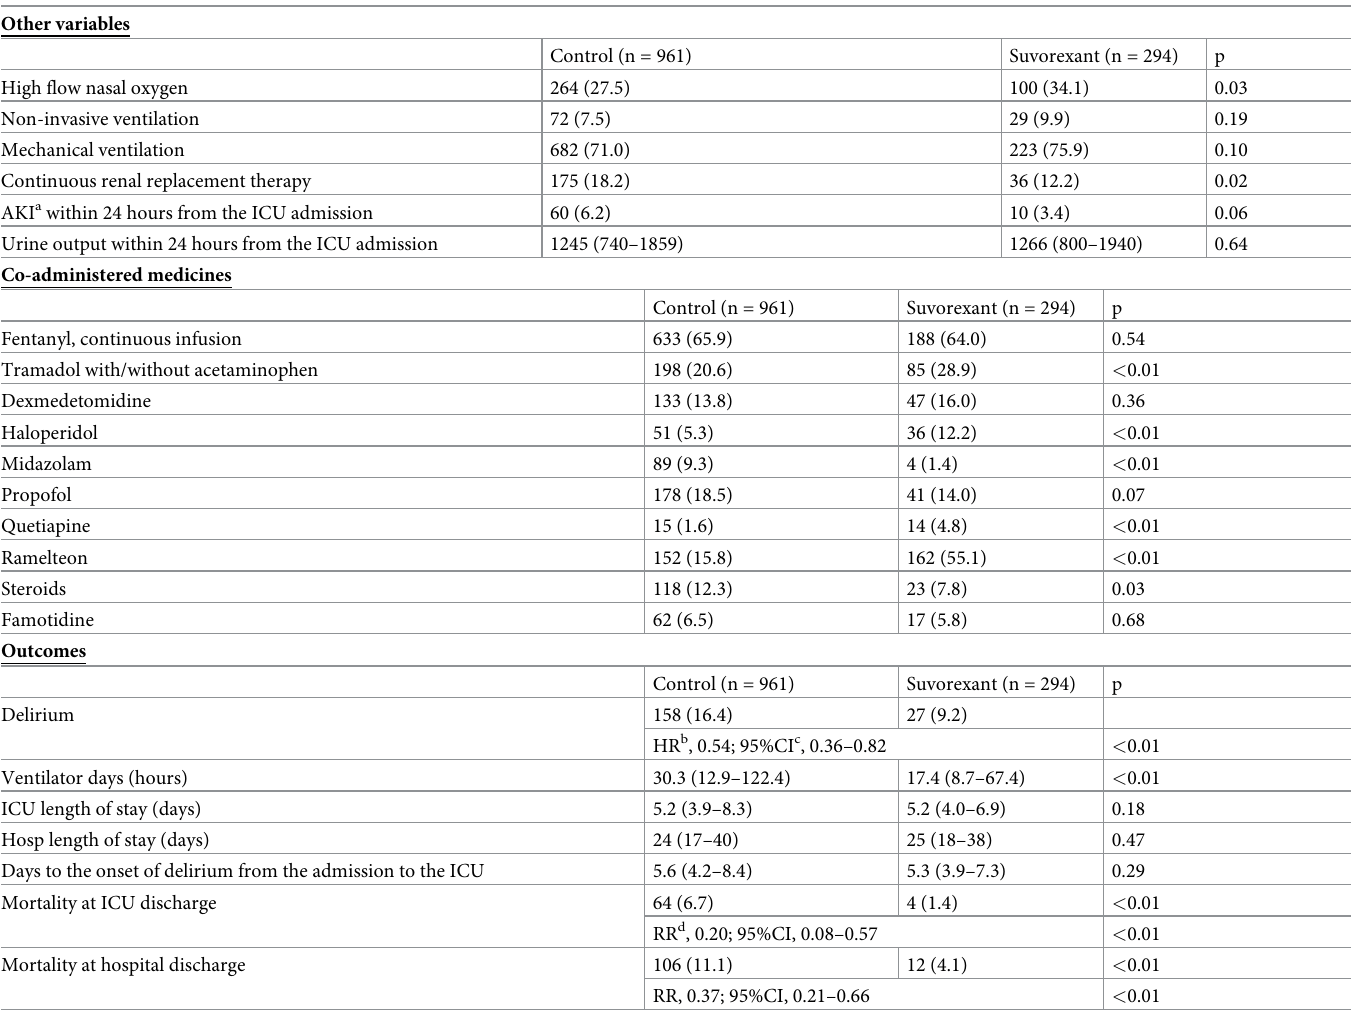
Table 3. Other variables, co-administered medicines at the ICU, and